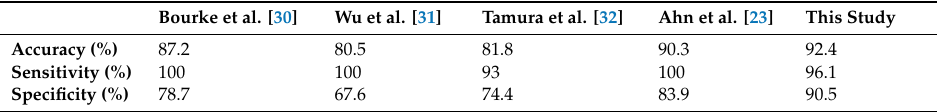
Table 4. Performance comparison with other similar